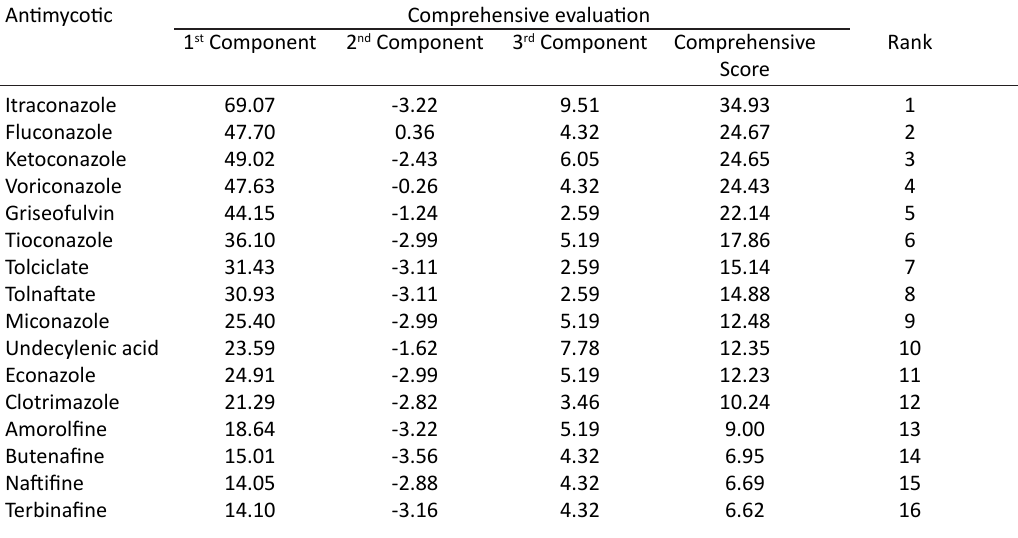
Table 3. Comprehensive scores of the antimycotics using principal component analysis.